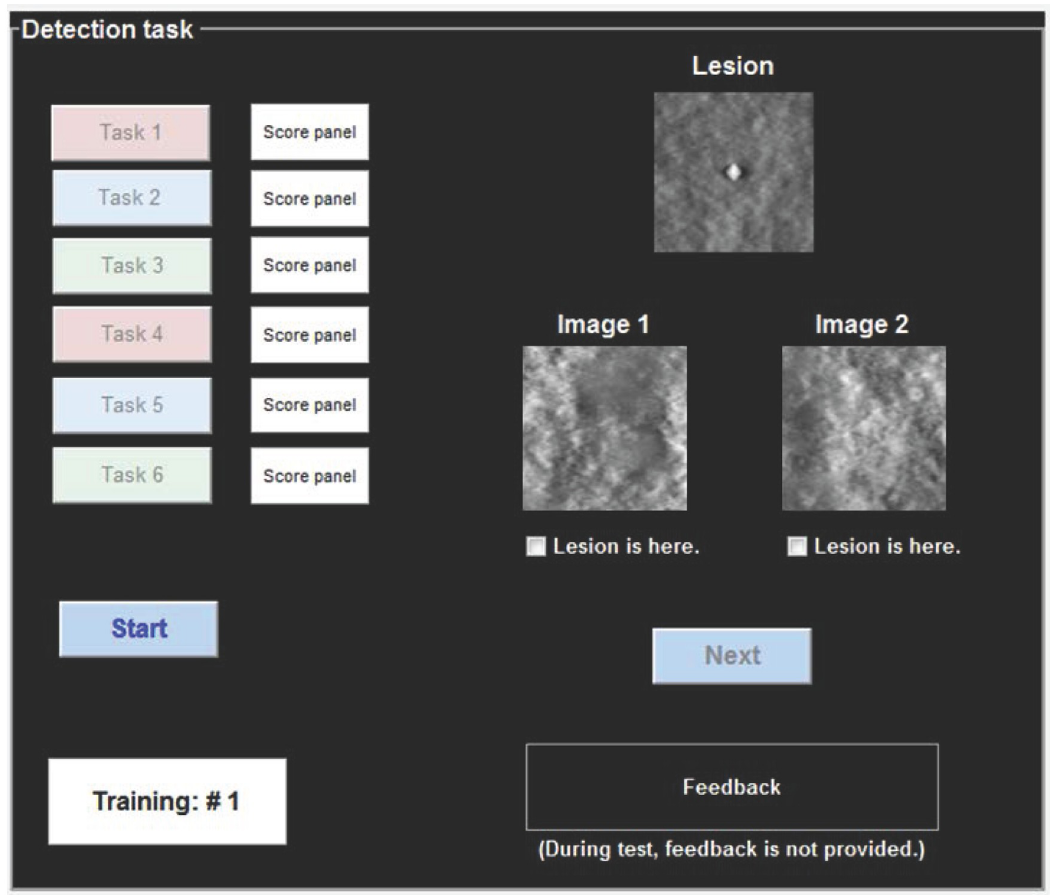
Fig 3. The binary detection task for the human observer study with respect to six detection tasks.